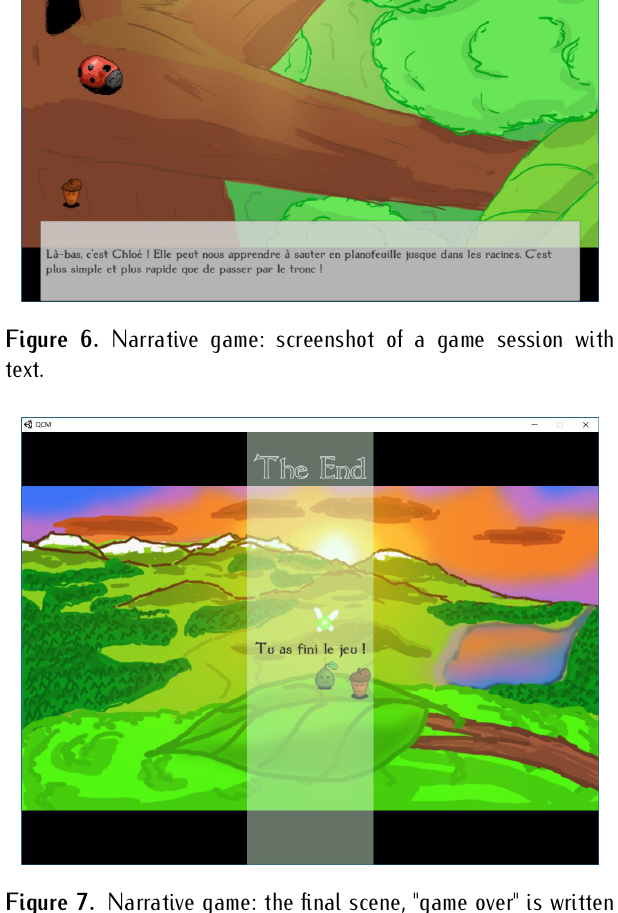
Figure 7. Narrative game: the final scene, "game over" is written (in